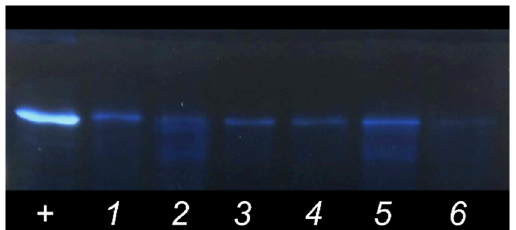
Figure 2. Protein visualization by gel silver staining with color inversion. Lanes are as follows: BSA solution 0.05 mg/mL (+); PC liposomes (1); 10PI liposomes (2); 2GM 1 liposomes (3); 10GM 1 liposomes (4); 10CMG liposomes (5); 2CMG liposomes (6). The protein binding (P B ) value was calculated as a relation between protein mass (g)